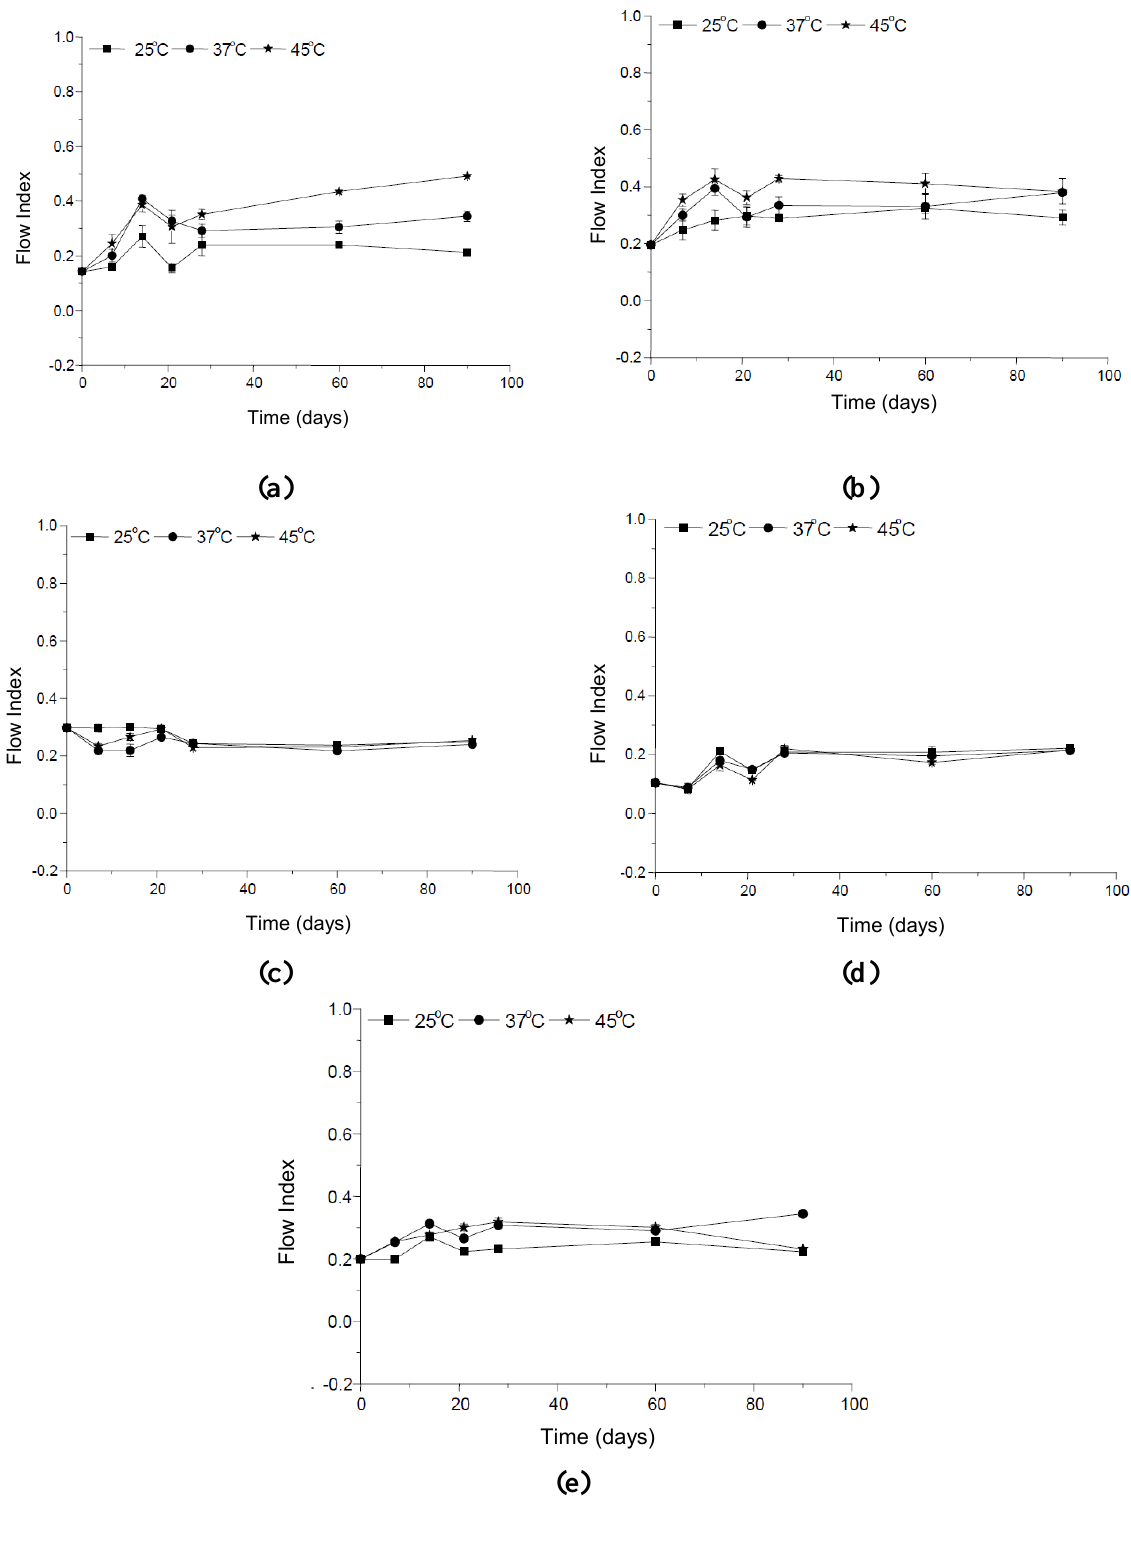
Figure 5. Changes in the flow index versus storage time at different temperatures ( a ) formulation vehicle; ( b ) formulation containing the organic UV filters; ( c ) formulation supplemented with CePO ; ( d ) formulation supplemented with TiO 4 supplemented with